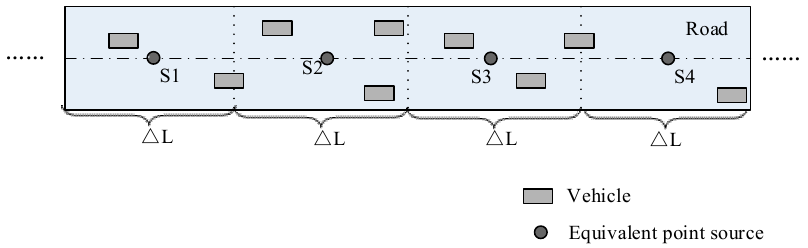
Figure 2. Discretization of a linear road source.